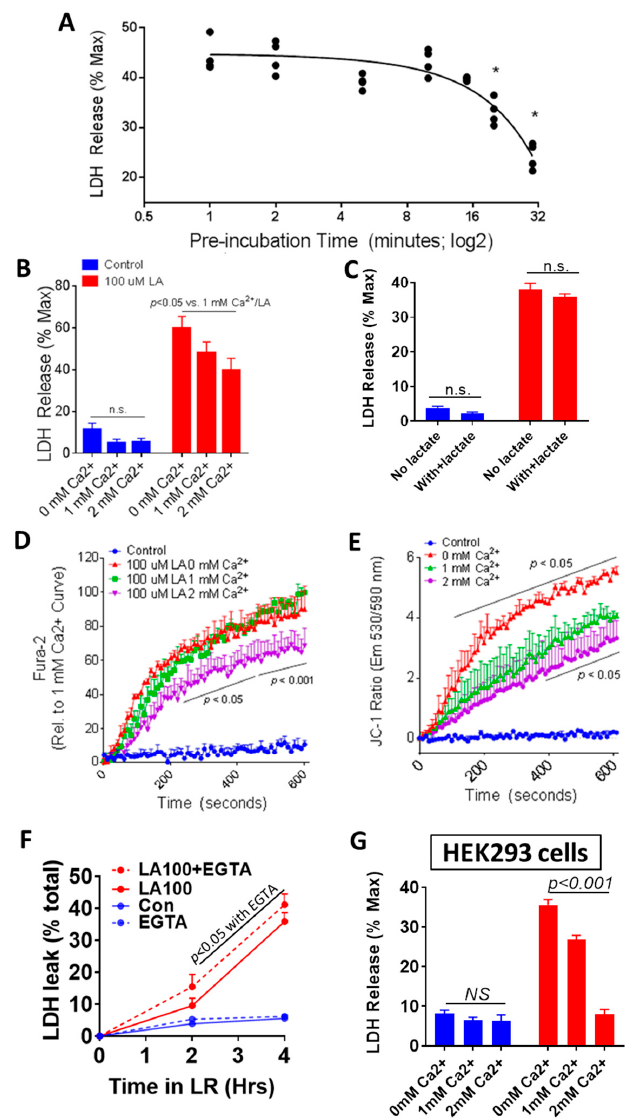
Figure 2. Extracellular calcium reduces LA-induced acinar cell injury in vitro. ( A ) Time course of the e ff ect of di ff erent durations of preincubating LA with calcium at 37 ◦ C prior to exposure to primary pancreatic acini, showing its impact on LDH release into the medium of the acini. ( B ) Extracellular calcium dose-dependently reduces 100 µ M LA-induced acinar LDH release over 4 h (red bars) without a ff ecting control cell viability (blue bars). ( C ) Supplementation with 10 mM sodium lactate had no e ff ect on either baseline cell viability or 100 µ M LA-induced acinar cell injury. E ff ect of di ff erent doses of extracellular calcium (0 mM red line, 1 mM green line, 2 mM purple line) on 100 µ M LA-induced intracellular calcium elevation ( D ) and mitochondrial depolarization ( E ). ( F ) Chelation of extracellular calcium (1 mM) with EGTA (1 mM) to nominally absent levels increased LA-induced acinar cell injury (dotted red line) at 2 and 4 h. ( G ): Extracellular calcium dose-dependently reduces 100 µ M LA-induced LDH release from HEK293 cells over 4 h (red bars) without a ff ecting control cell viability (blue